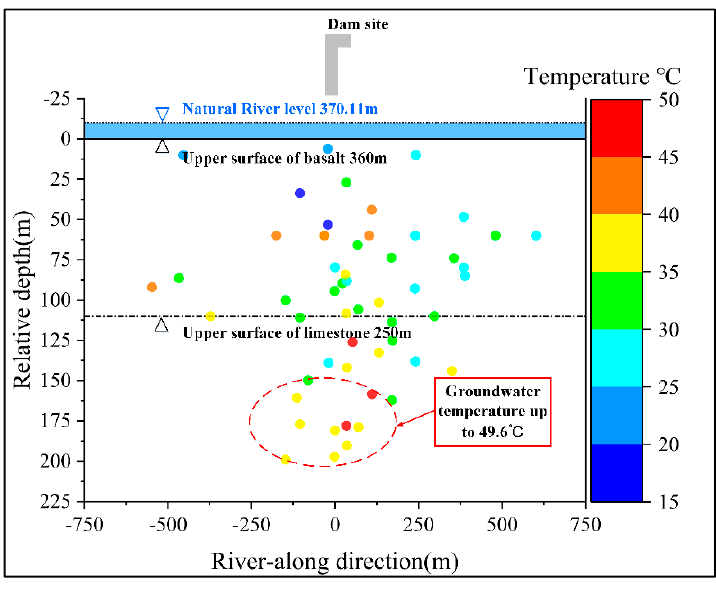
Figure 3. Measurement during pre-project exploration, the high geothermal phenomenon is revealed near the dam site.